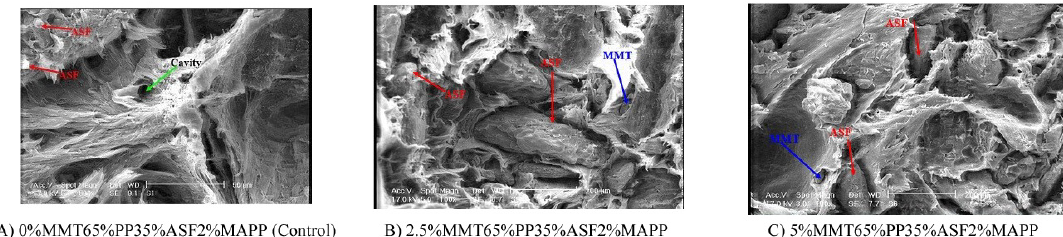
Figure 5. The SEM images of the cross section of the composite specimens (MMT: montmorillonite; PP: polypropylene; ASF: almond shell flour; MAPP: coupling